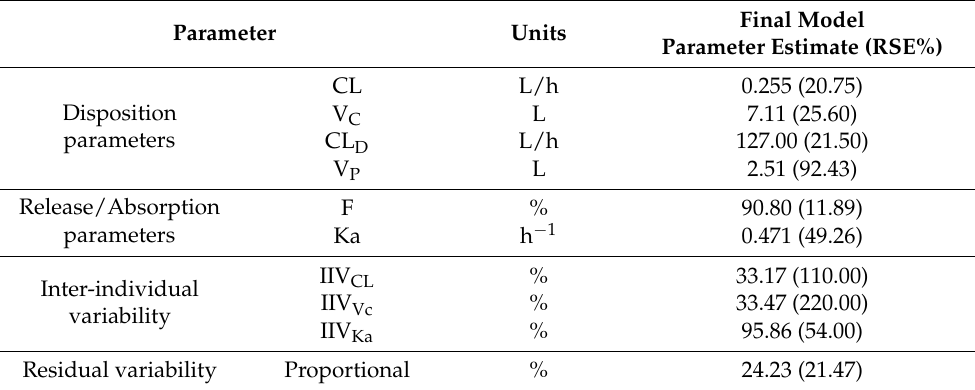
Figure 3. Predictive check of the pharmacokinetic model for CP after the IV and IM administrations. The VPCs were constructed from the fixed and random estimates obtained from the final selected model. One thousand concentration–time profiles were simulated using Monte Carlo simulations after each administration route and their non-parametric 95% confidence intervals (the 2.5th and 97.5th percentiles) were calculated and represented together with the observed data for visual inspection. The circles represent the observed data. Dashed lines depict the 2.5th and 97.5th percentiles of the simulated concentrations. The solid line corresponds to the 50th percentiles of the simulated concentrations. VPC showed that most of the data fell within the 90% prediction interval and were symmetrically distributed around the median both after IV and IM administrations. Table 5. Mean (relative standard errors, RSE%) values of the disposition and absorption pharmacokinetic parameters estimated by the final model.